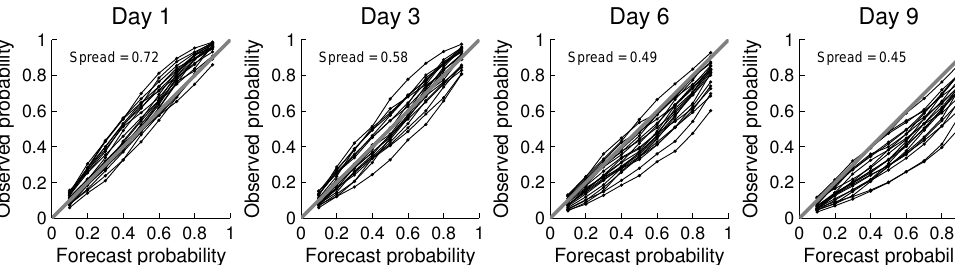
Figure 6. Reliability of the EnKF multimodel ensemble (system G) for all individual catchments. The spread represents the square root of mean ensemble variance averaged over all catchments.